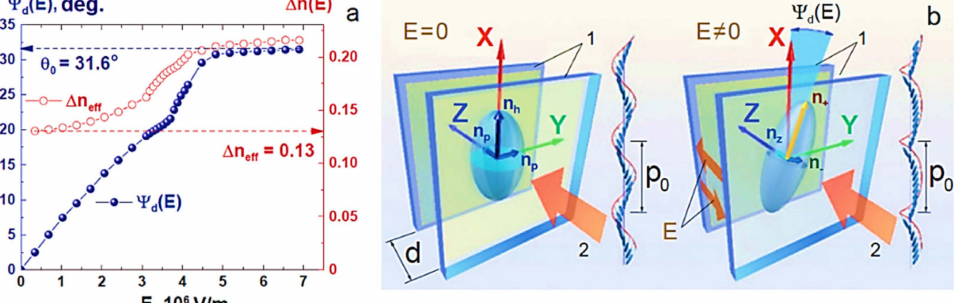
Figure 4. ( a ) Dependences on the electric field of the effective birefringence ∆ n eff ( E ) ( red circles ) and the deviation of the main optical axis Ψ d ( E ) ( blue balls ) of the planar-aligned liquid DHFLC-587-F7 with the helix pitch around 65 nm, developed in [73]. The measurements were carried out at 22 ◦ C at a wavelength λ = 632.8 nm; ( b ) illustration of the biaxial transformation of the effective refractive index ellipsoid of the DHFLC in an electric field in a planar-aligned DHFLC cell (the same geometry as in Figure 1c). Numeral 1 denotes transparent conductive substrates, arrow 2 shows the direction of propagation of linearly polarized incident light, the same as in Figure 1c. All images are taken from